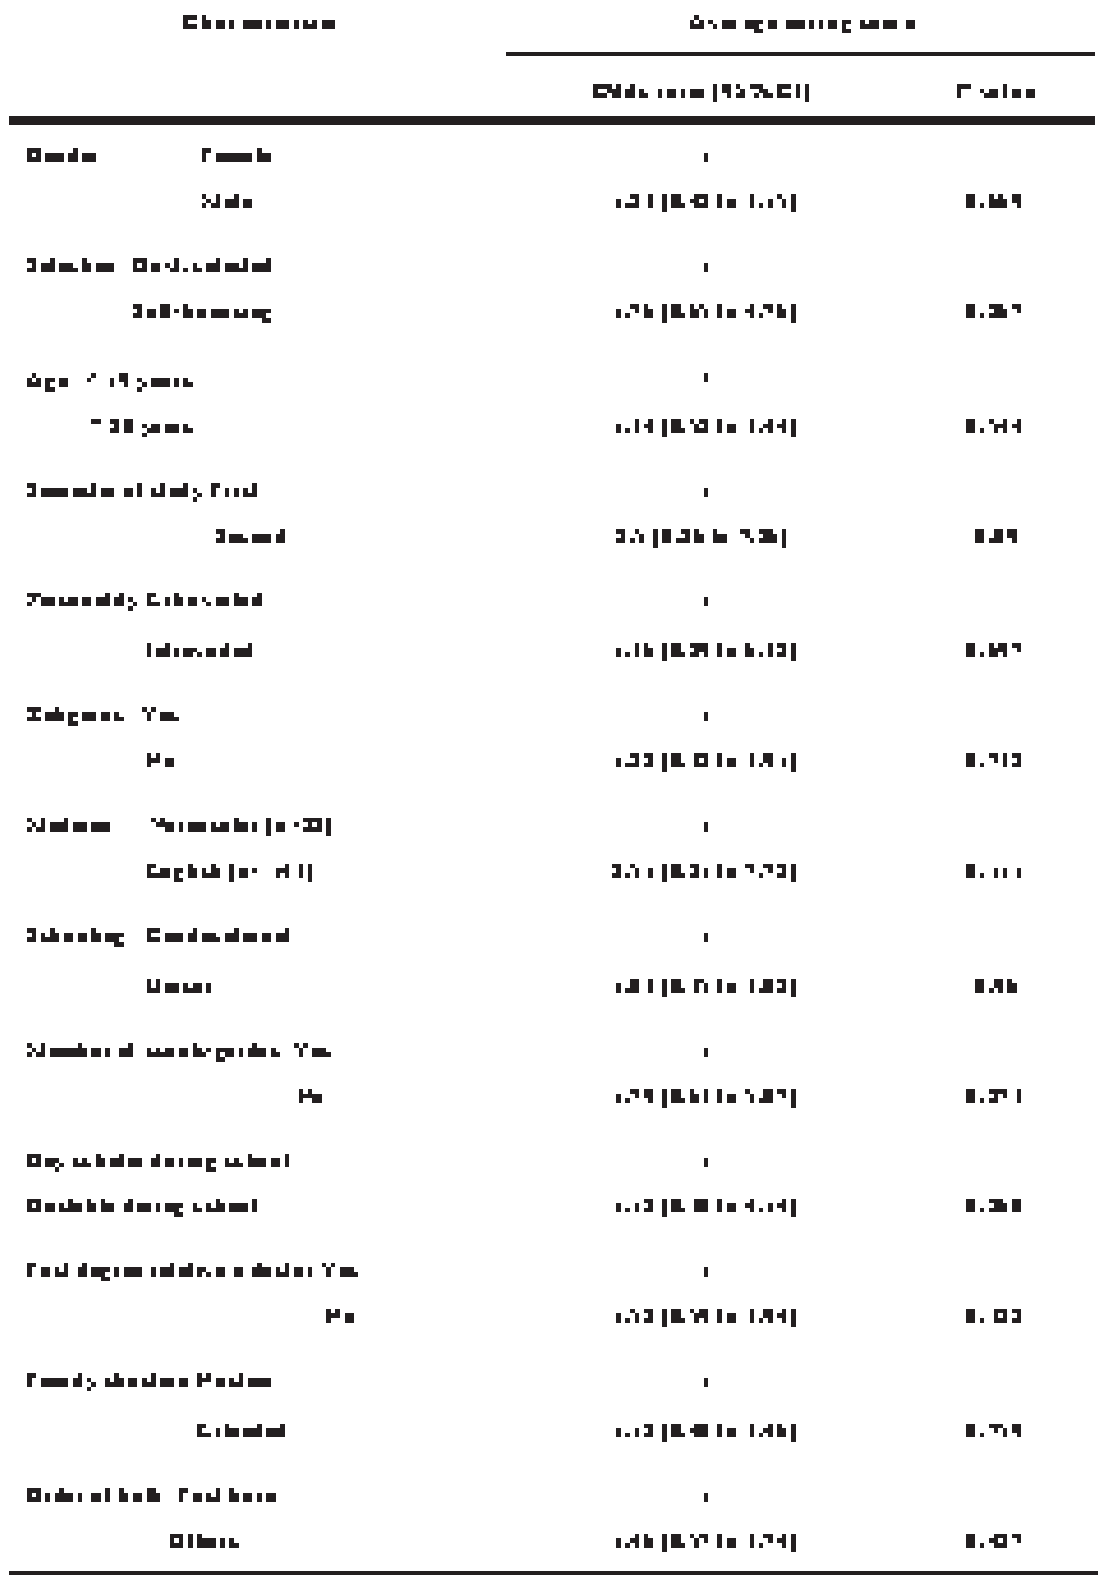
Table III : Factors associated with the average caring scores of students